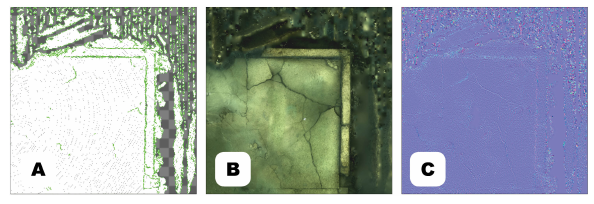
Figure 10. (A) UV Map (B) Diffuse Map Texture (C) Normal Map Texture